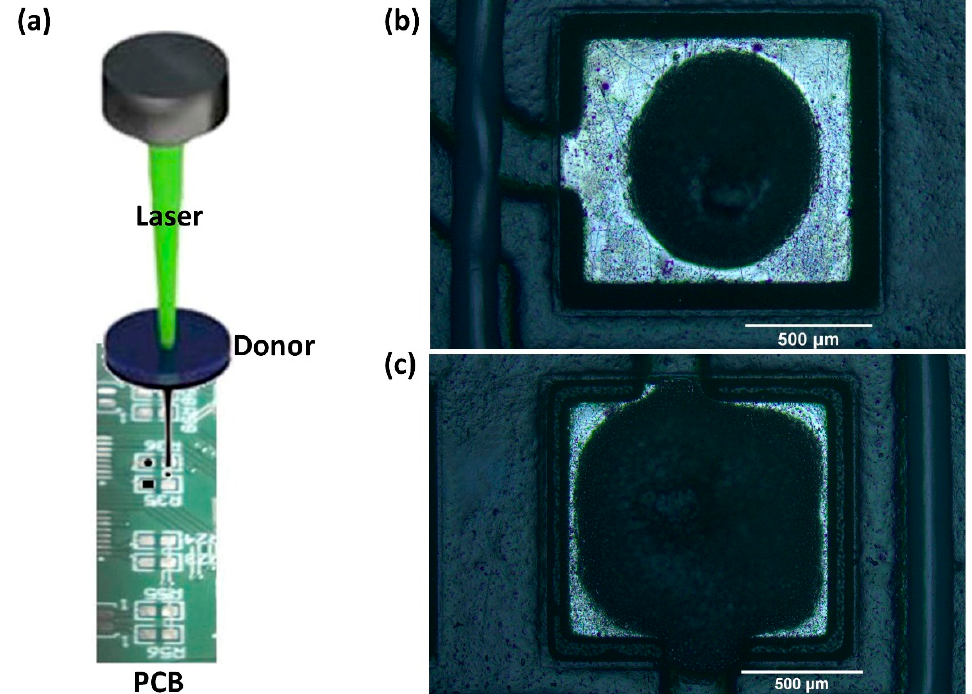
Figure 6. ( a ) Schematic of LIFT printing of solder paste on PCB pads, ( b ) resulting printed